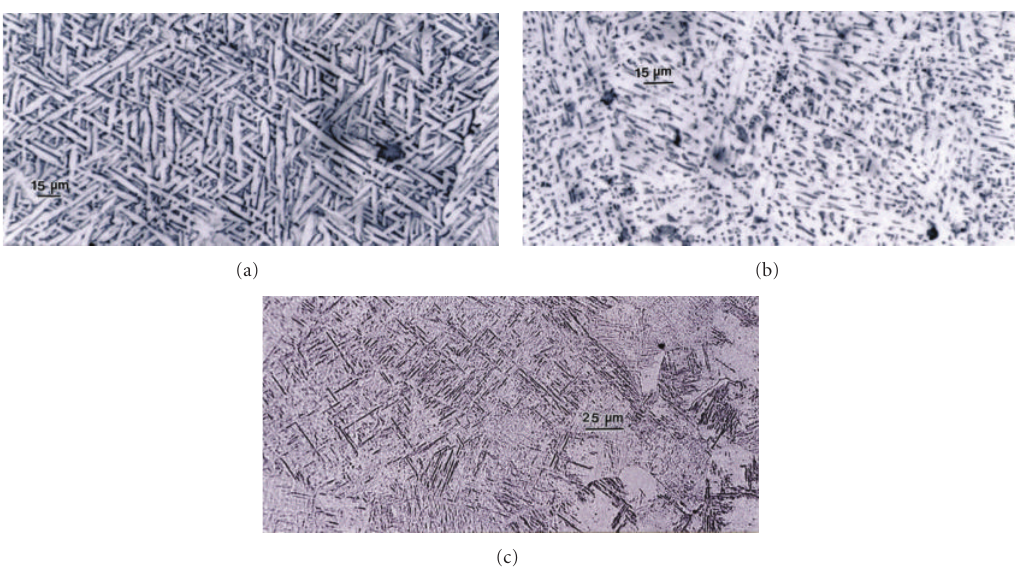
Figure 9: Comparison of Ti-6Al-4V solid, cylindrical component microstructures. (a) EBM ( z ) component α -phase (acicular) plates. (b) EBM ( x , y ) component fine α + β structure. (c) α + α (cid:4) martensite structure for mesh component as in Figure 8(b). Corresponding Vickers